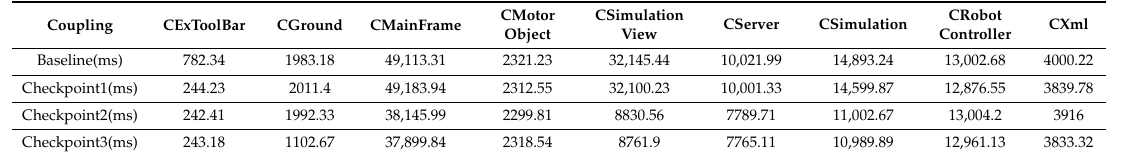
Table 4. Performance results.